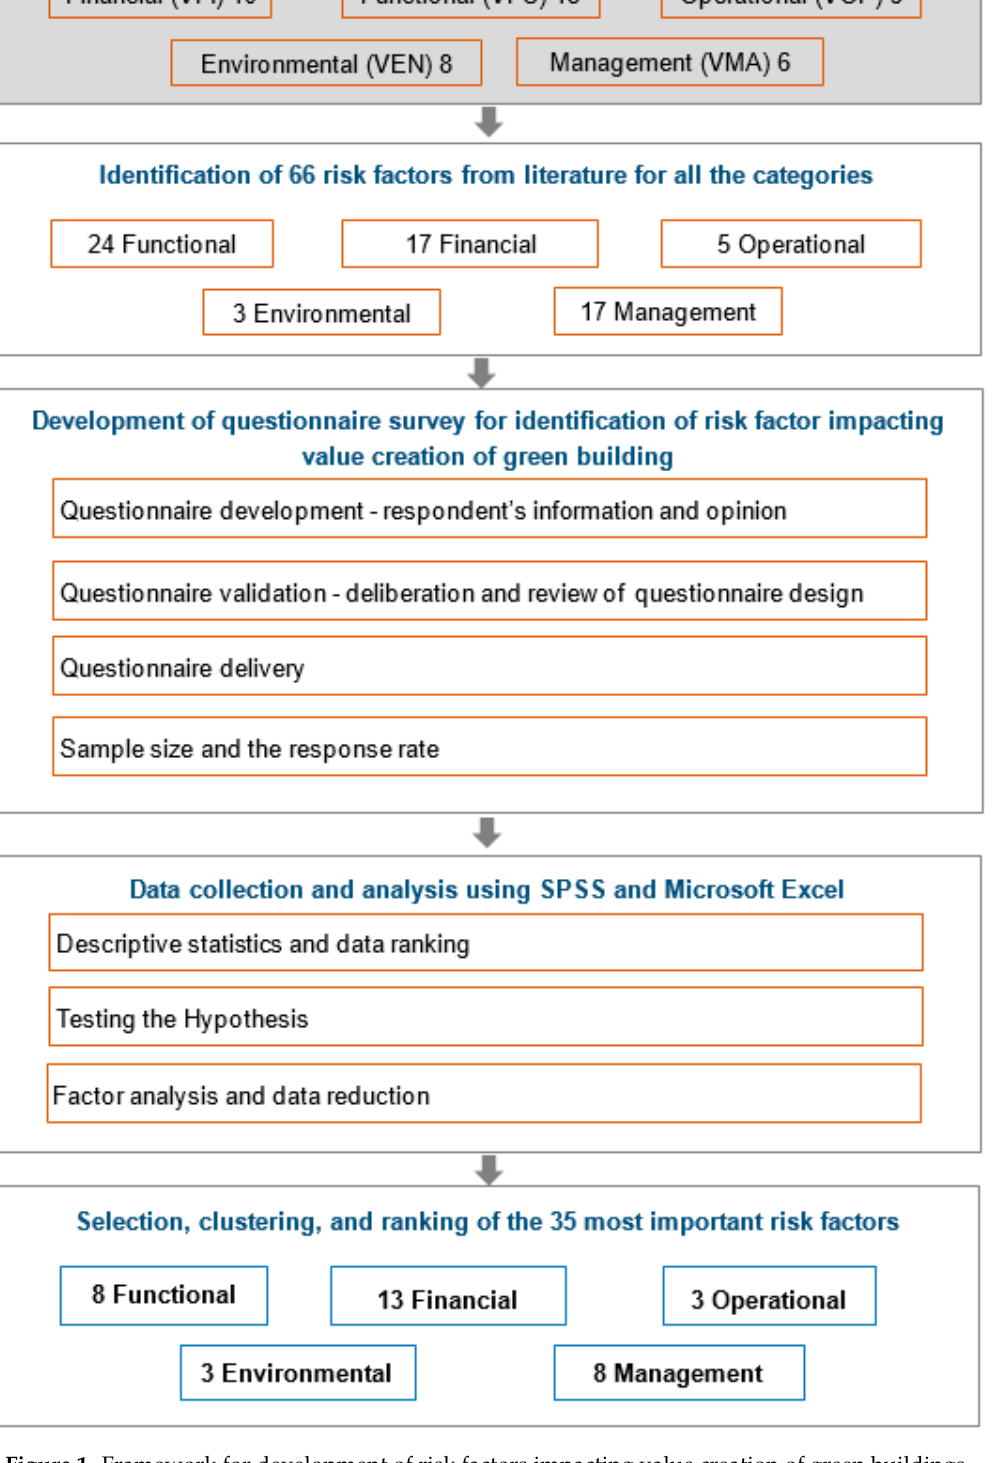
Figure 1. Framework for development of risk factors impacting value creation of green buildings .